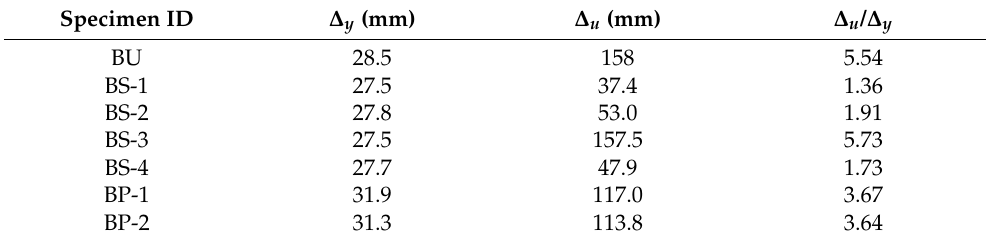
Table 4. Comparisons of the ductility index.